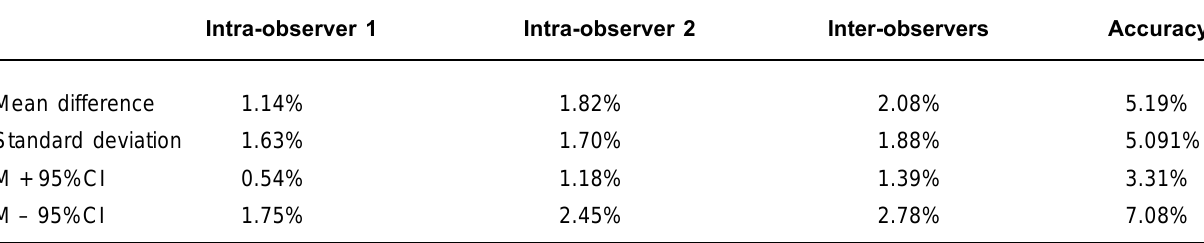
TABLE 1 - Statistical analysis of measurements in maxillary sinus without lesion